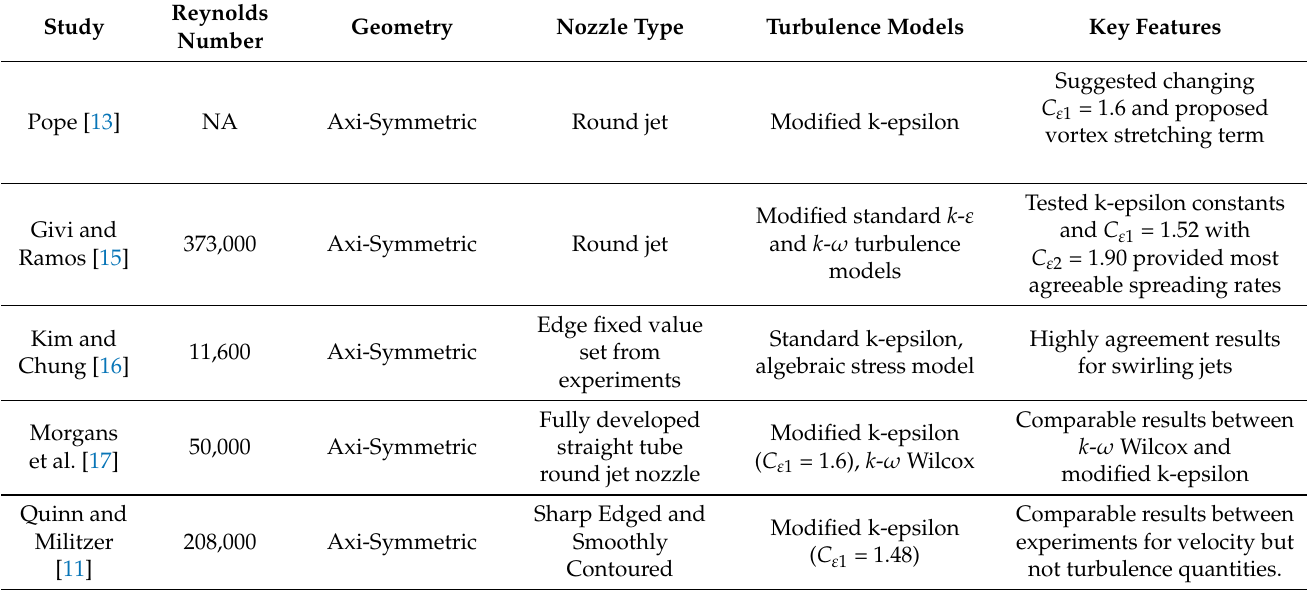
Table 1. Relevant RANS numerical studies on turbulent jets. Studies include fundamental work and modifications that were performed to help mitigate the problems associated with spreading